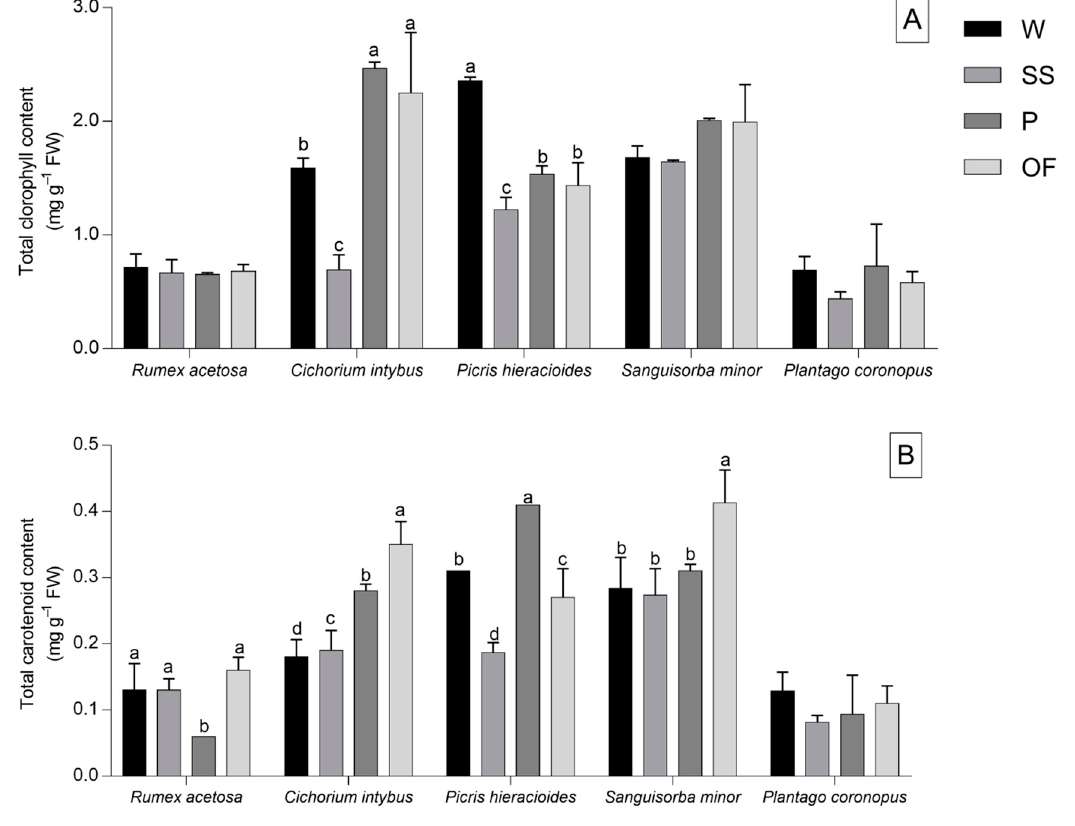
Figure 3. Total chlorophyll ( A ) and carotenoid ( B ) contents of Rumex acetosa , Cichorium intybus , Picris hieracioides , Sanguisorba minor , and Plantago coronopus wild-collected (W) and domesticated according to three di ff erent methods: “soilless” (SS), pot (P), and open field (OF). Each value is the mean ( ± SD) of three replicates. Means keyed with a di ff erent letter are significantly di ff erent and means not keyed with letters are not significantly di ff erent for p = 0.05, considering each species independently and following one-way ANOVA, with wild-collection or the di ff erent domestications as the variability